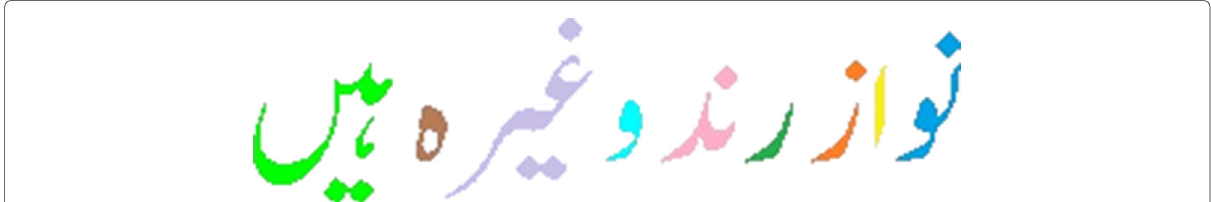
Fig. 11 Primary ligatures with respective secondary ligatures association (same color) forming complete